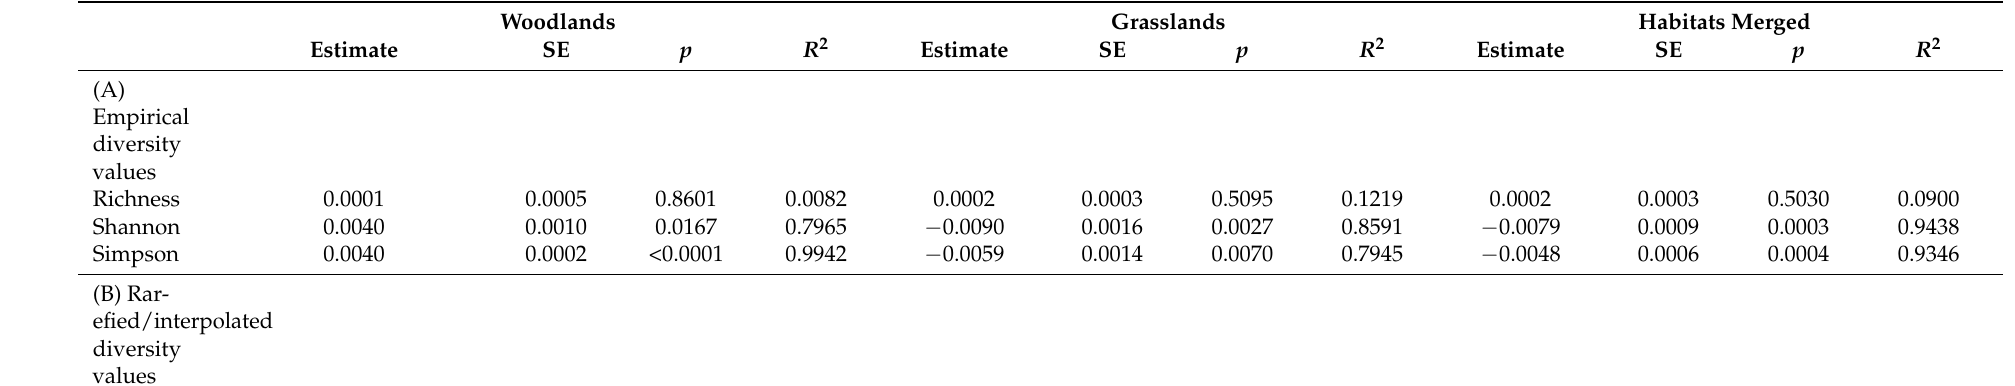
Table 2. Results of generalized linear models for the relationships of diversity ( A – C ) and abundance ( D ) of dung beetles with altitude along an elevational gradient in central Italy. Diversity (expressed as species richness, Shannon diversity, and Simpson diversity) was calculated using empirical ( A ), rarefied/interpolated ( B ), and asymptotic ( C ) values. Analyses were conducted for the two habitats (woodlands and grasslands), both separately and merged. SE = standard error, p = probability, R 2 = Kullback–Leibler-divergence-based R 2